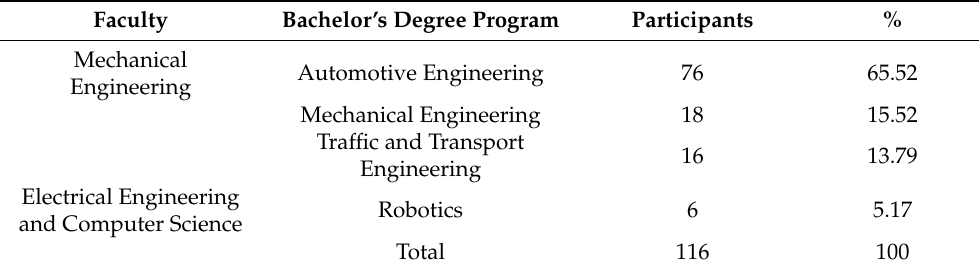
Table 4. Participants by subjects and